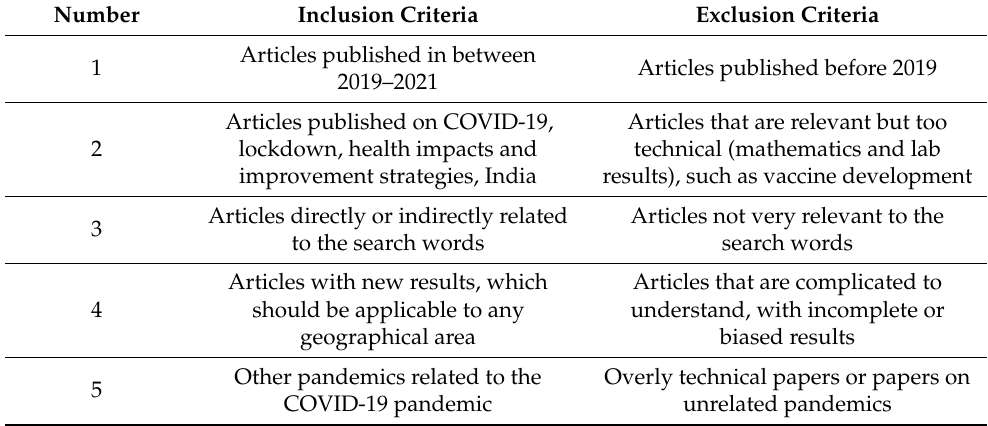
Table 1. Inclusion and Exclusion